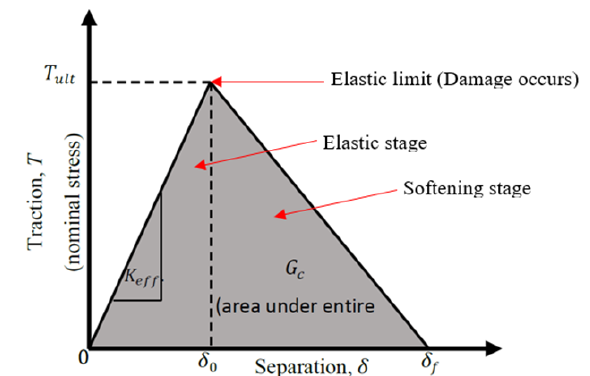
Fig. 3. Bilinear softening of the traction-separation response ([18]